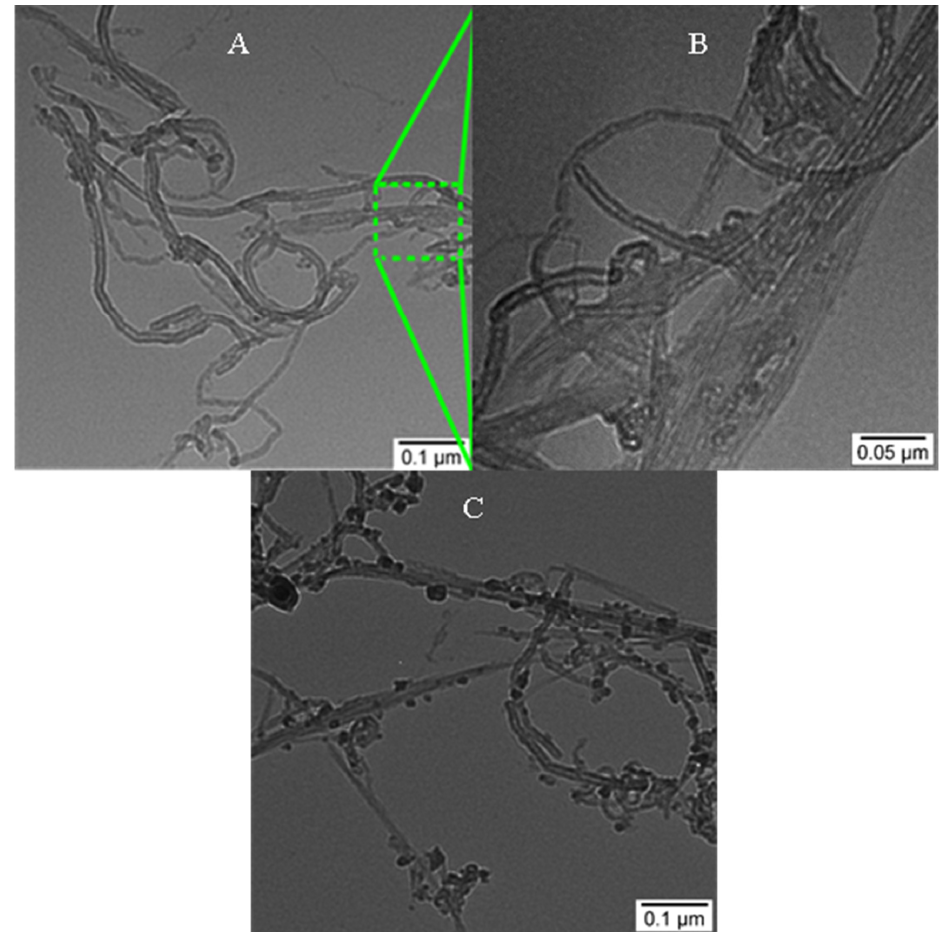
Figure 7. Transmission electron microscopic images of SWCNT-NH 2 /SDS ( A ) and ( B ) and SWCNT-NH 2 /DoTAB ( C ). Image B shows the amplification of the area marked in green in the image A. The samples were prepared in a buffer solution NaH 2 PO 4 0.01 M/NaCl 0.02 M, pH 3.